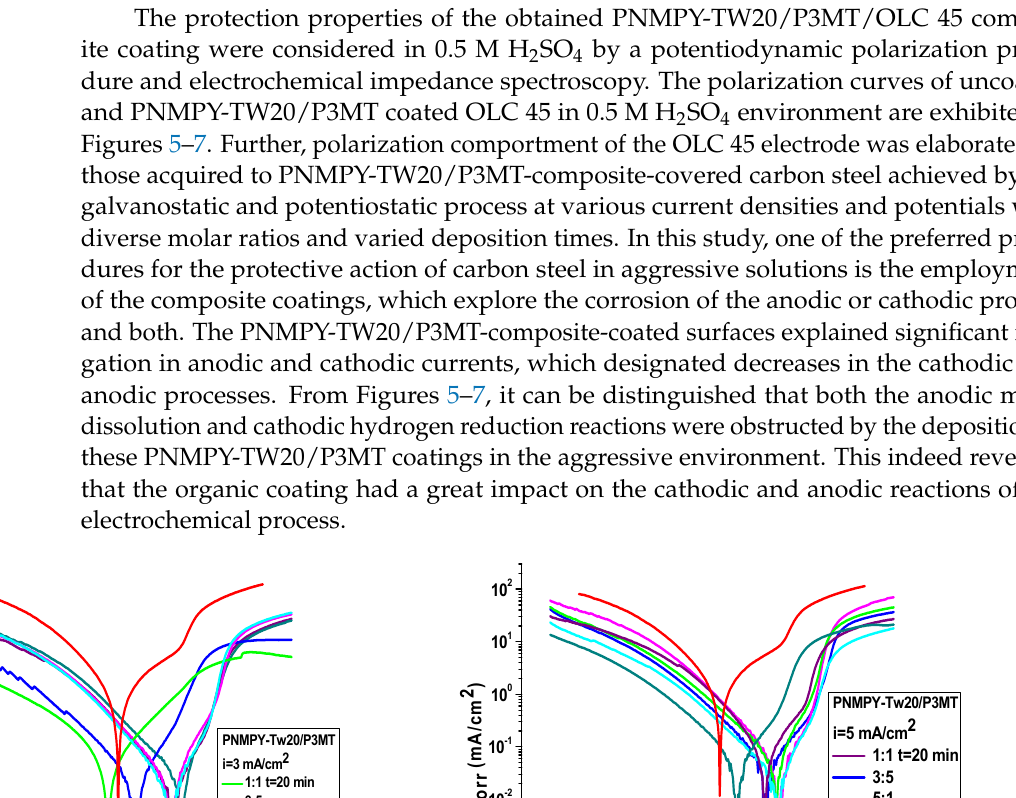
Figure 6. Polarization curves of PNMPY-TW20/P3MT coated and uncoated on OLC 45 electrode in 0.5 M H 2 SO 4 by potentiostatic procedure at 1.2 V ( a ) and 1.4 V ( b ) potential applied at differing molar ratio, and the electrodeposition has been admitted for 20 and 30 min.